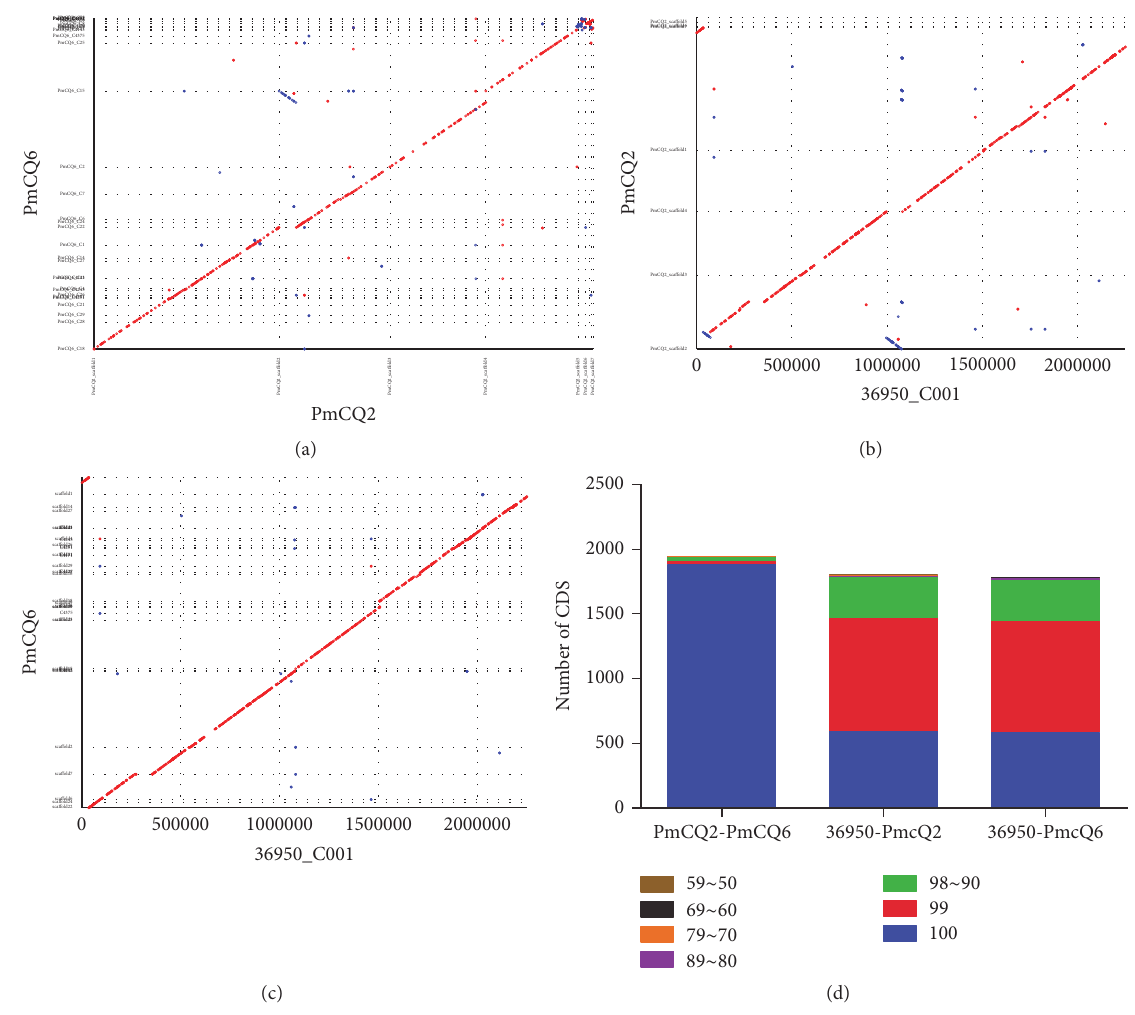
Figure 3: The global alignment analysis of three bovine Pm capsular type A genomes. Aligned segments are represented as dots or line. The alignment was generated by the mummerplot script and the Unix program gnuplot. (a) PmCQ2 and PmCQ6 genome sequences are given on the 𝑥 - and 𝑦 -axis, respectively. (b) Pm36950 and PmCQ2 genome sequences are given on the 𝑥 - and 𝑦 -axis, respectively. (c) Pm36950 and PmCQ6 genome sequences are given on the 𝑥 - and 𝑦 -axis, respectively. Dot plot indicted the alignment blocks of two genome alignment sequences; red and blue indicted the forward and the reverse sequence, respectively. (d) Direct comparison of the three nucleotide sequences using BLAST. The vertical coordinates are the number of genes. Percentage of genetic similarity is indicated by color